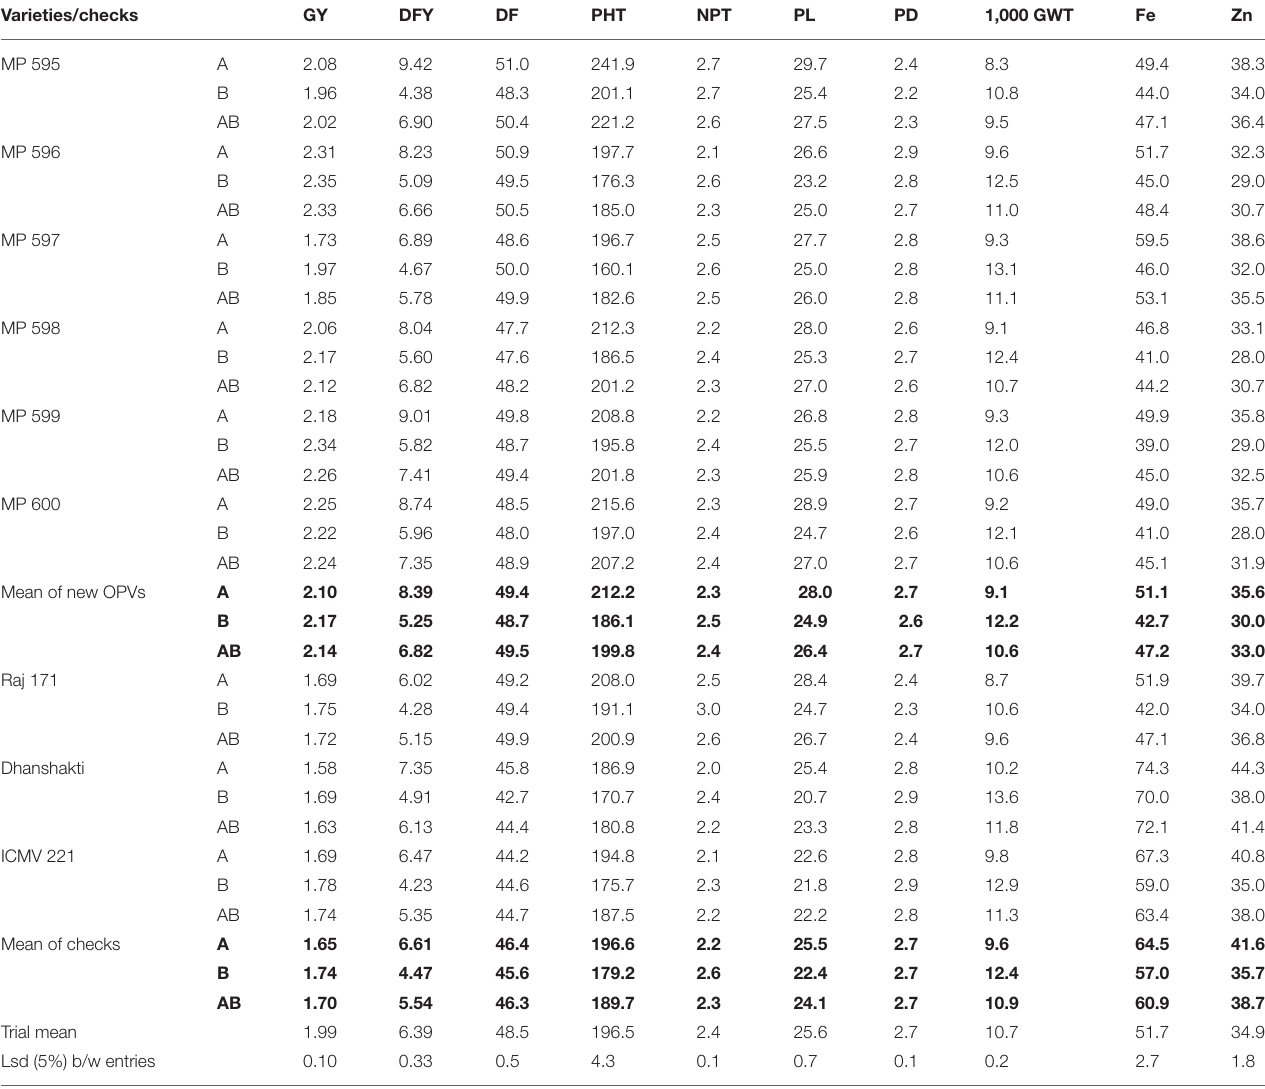
TABLE 4 | Performance of OPVs for grain yield and quality traits pooled across locations.